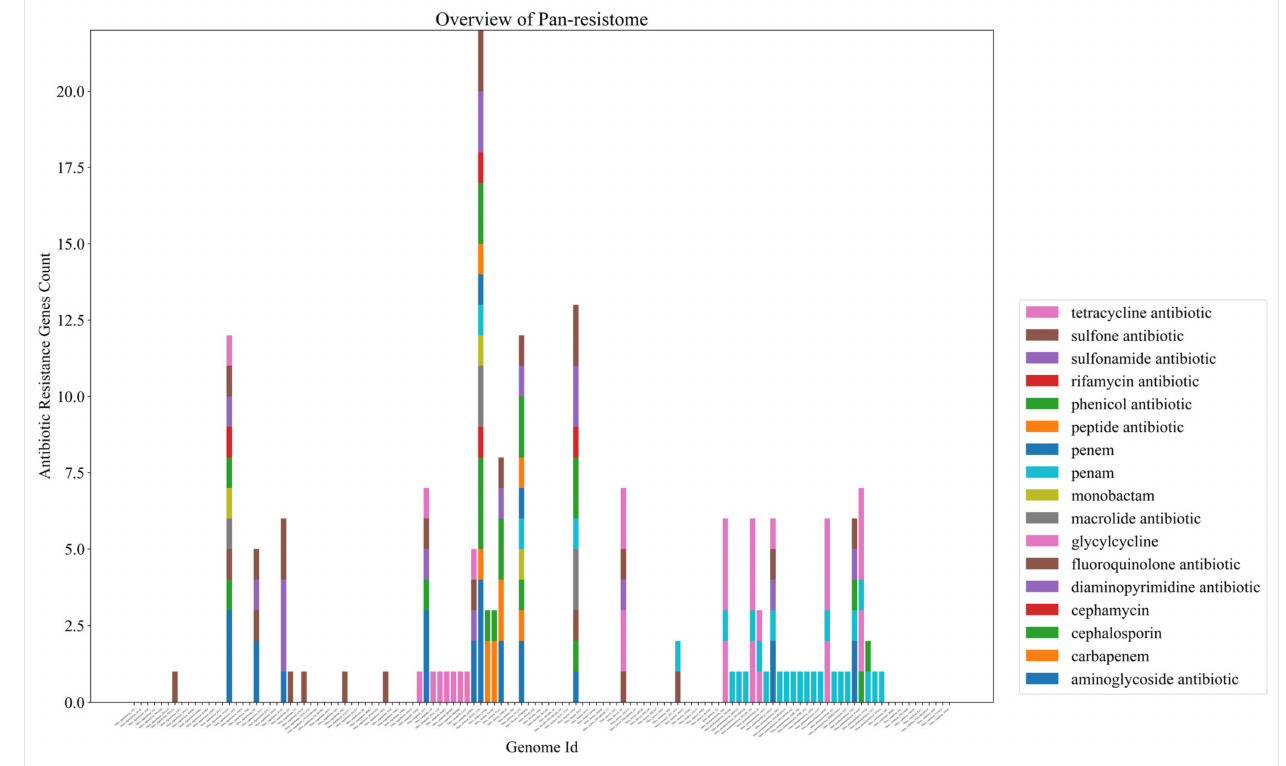
Figure 4. An overview of the pan-resistome of the Vibrio genus. Each bar per column corresponds to an ARG of a given genome. Each color represents resistance to a class of antibiotics, such as pink to tetracycline and light green to cephalosporin. For more details, check the chart in Supplementary Material